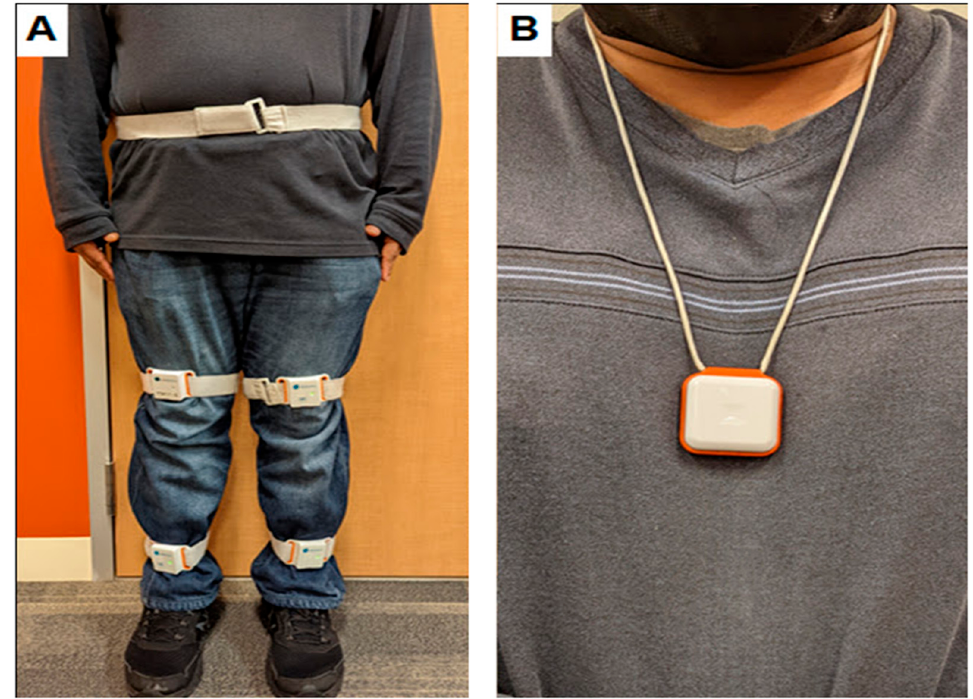
Figure 1. ( A ) Wearable sensors and their placement for gait and balance performance assessments. ( B ) A pendant sensor and its placement for physical activity assessments.